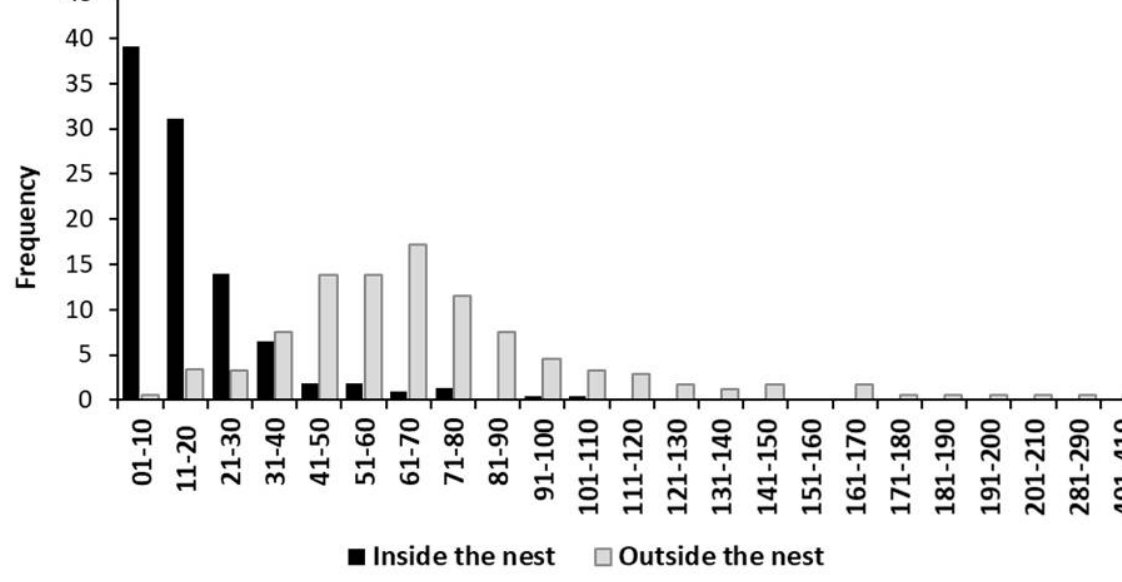
Fig 4. Time spent by Epicharis dejeanii females inside the nest on cell provisioning (N = 215 records) and outside the nest on foraging trips (N = 174 records) during the observation period. Results are shown in 23 frequency distribution classes (in intervals of 10 min).